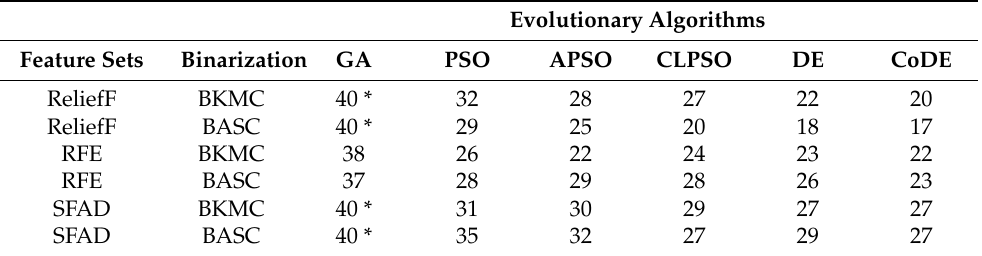
Table 6. Earliest generation to converge to best